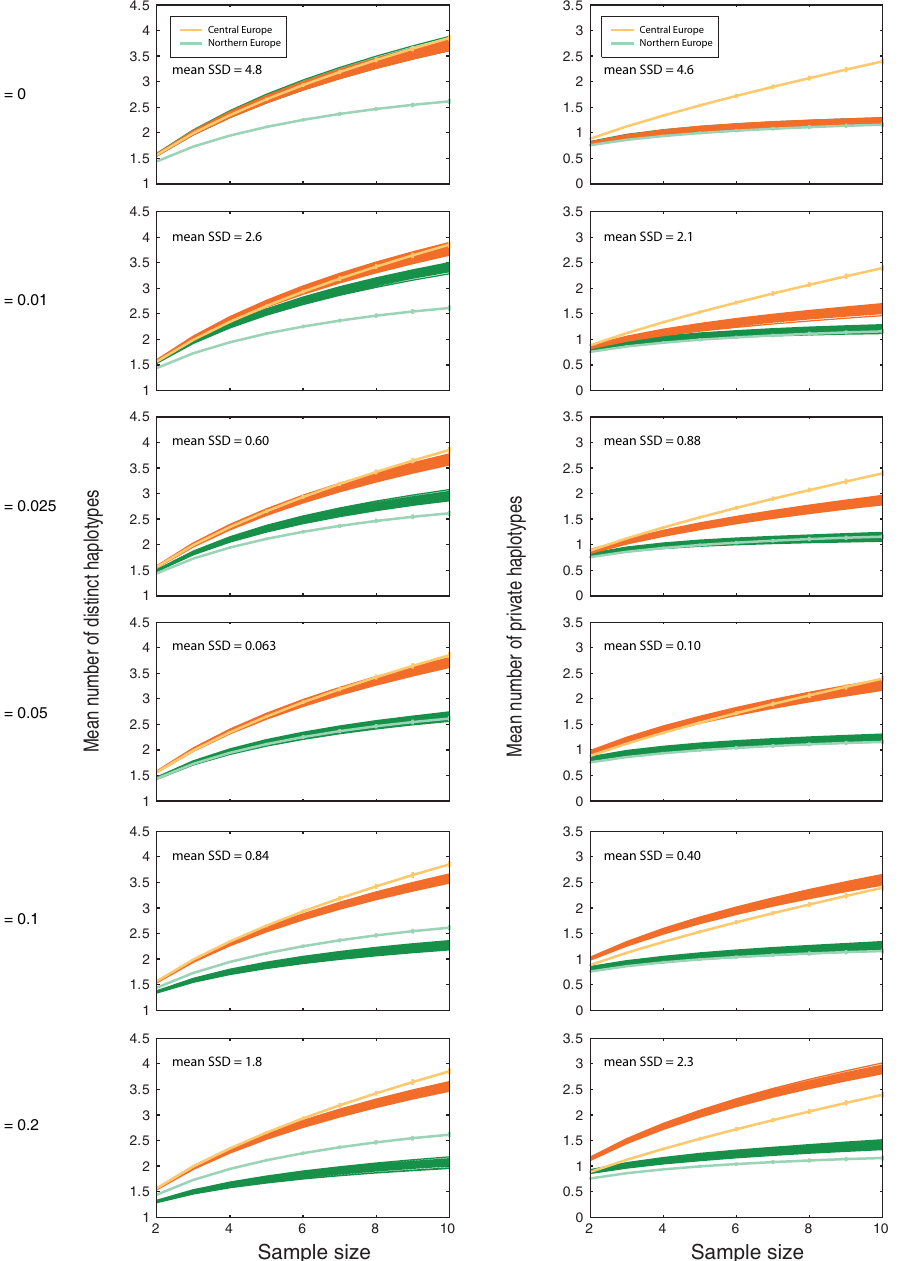
Figure 6. Estimation of the splitting time between the northern and central European populations of A.thaliana . The mean number of distinct haplotypes and the mean number of private haplotypes of two simulated populations, as functions of sample size. The dark orange lines show the simulation results for a population of size 135,000, and the dark green lines show the simulation results for a population of size 135,000 6 1/ 4. The top panel shows the case when the split time is 0. Below follow the results for increasing split times. No migration is assumed. The split time T is given in units of population size. The fit of the simulated data to the observed data was evaluated by the mean across the 100 simulations of the sum of squared differences (SSD) between each simulated data set and the observed